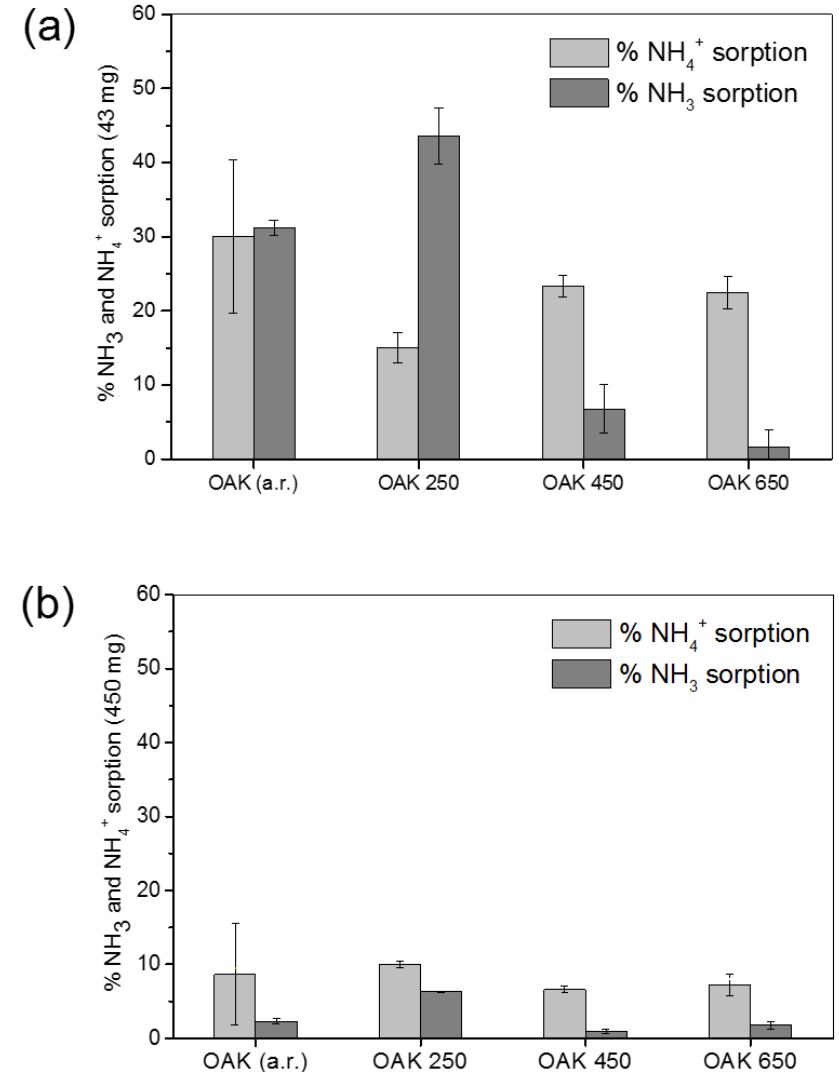
Figure 2. NH 3 and NH 4+ removal efficiencies of unprocessed oak biomass (as received) and oak chars at approximately ( a ) 43 mg NH 3 and 43 mg NH 4+ L − 1 ( b ) 450 mg NH 3 and NH 4+ L − 1 . Based on duplicate data and error bars represent deviation around the mean.